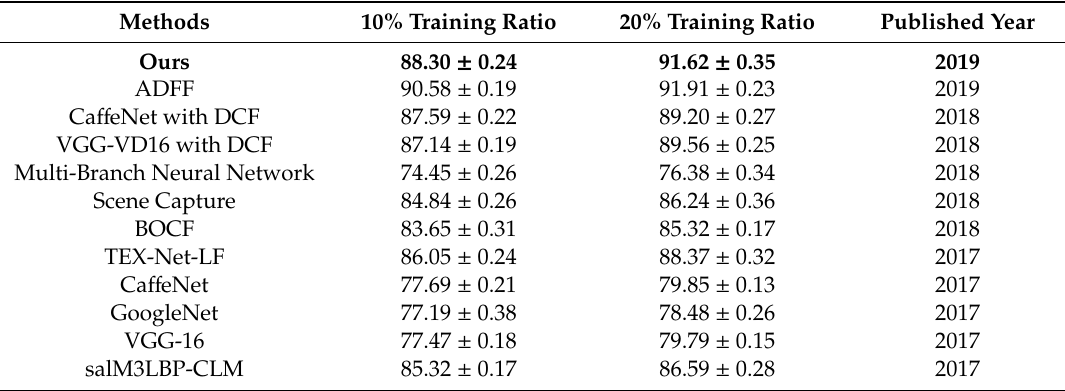
Table 4. The OA of the models on NWPU-RESISC45